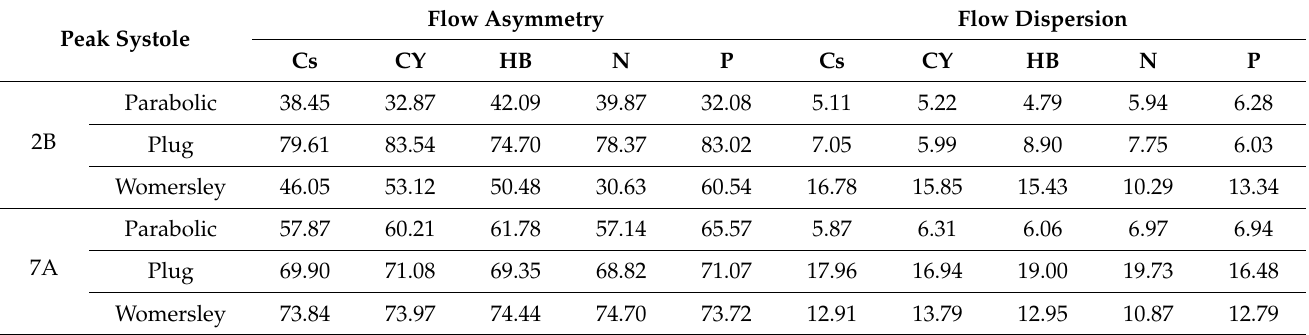
Table 5. Percentage values for flow asymmetry and